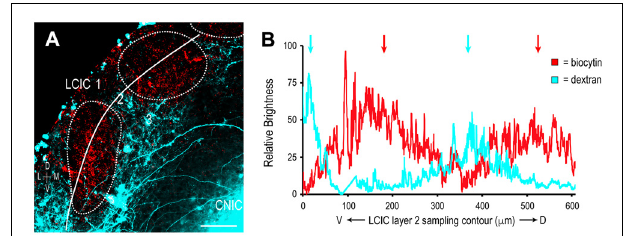
FIGURE 9 | Segregation of multimodal LCIC projection patterns at P12. Somatosensory inputs (red) target layer 2 modules (dashed contours), while auditory inputs (cyan) distribute throughout the encompassing matrix (A) . A corresponding brightness plot profile confirms non-overlapping terminal patterns (arrows) at P12 (B) . Scale bar = 100 µ m.